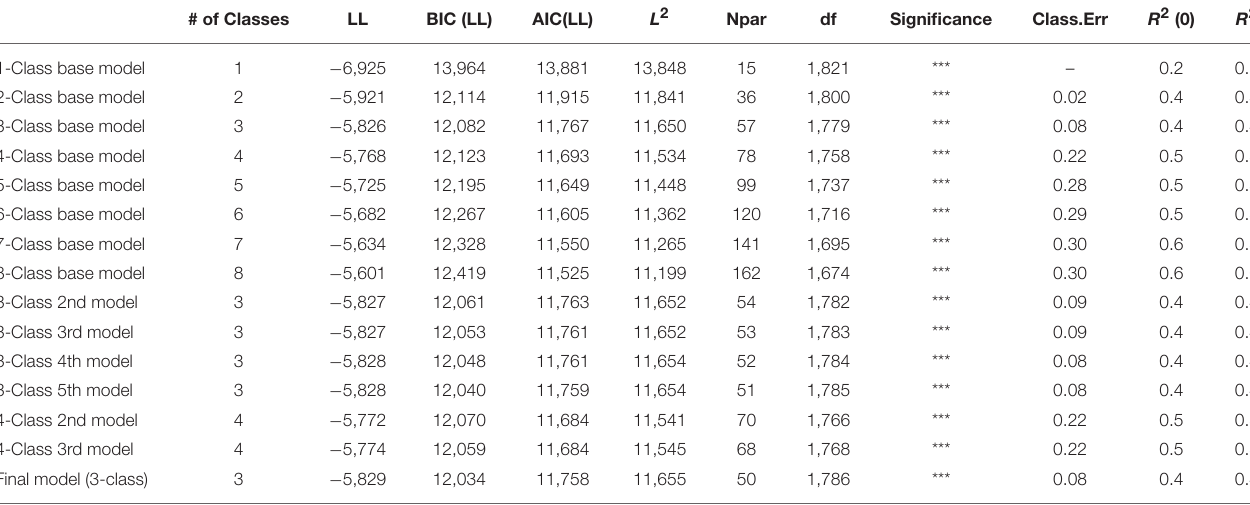
TABLE 4 | Model selection for the main urban resident sample ( n = 1,859).